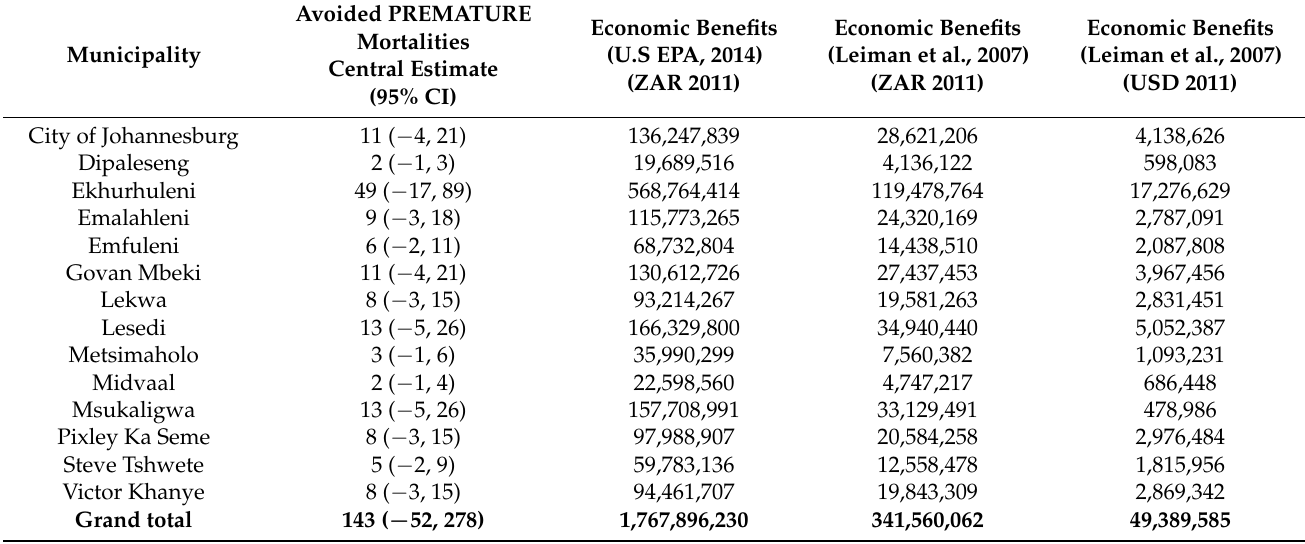
Table 5. Summary of health and economic benefits per